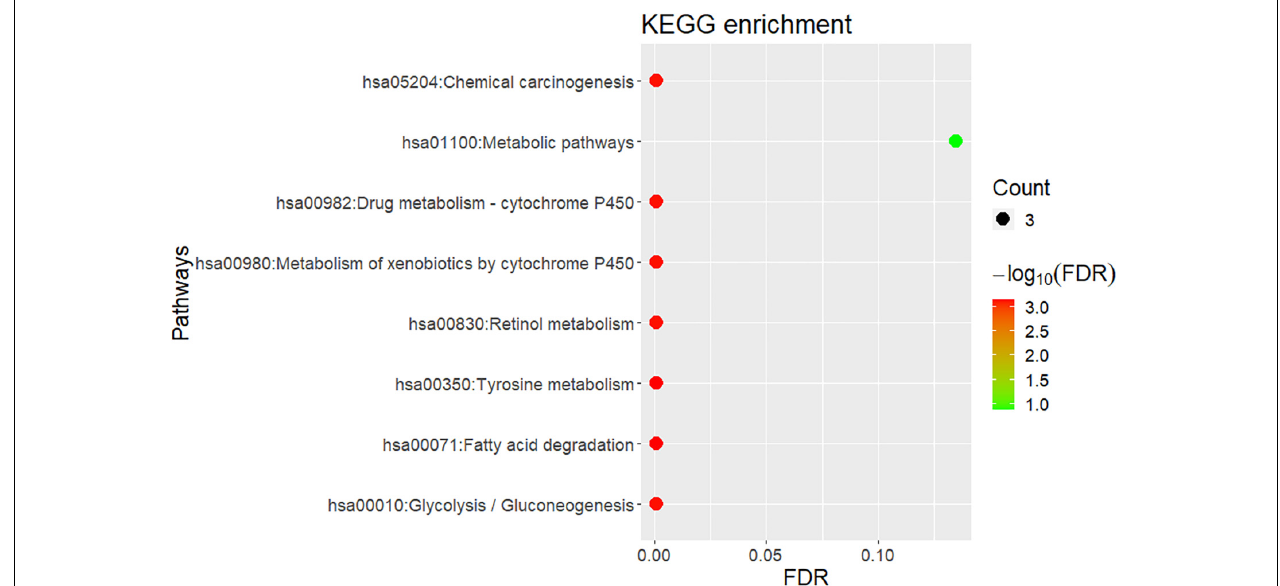
FIGURE 4 | Bubble chart of KEGG pathway enrichment for gingivitis-related genes.